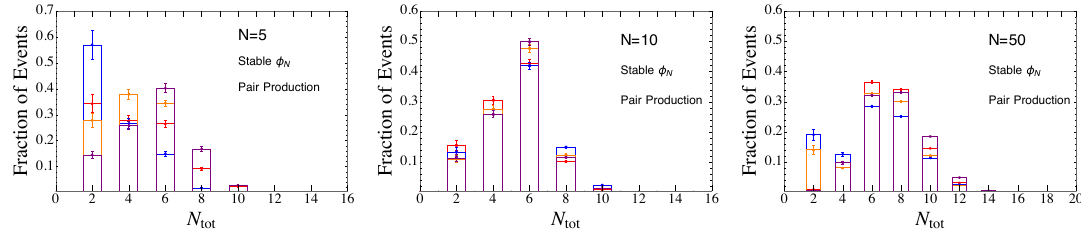
-symmetric scenario where a SM = a = 0 2